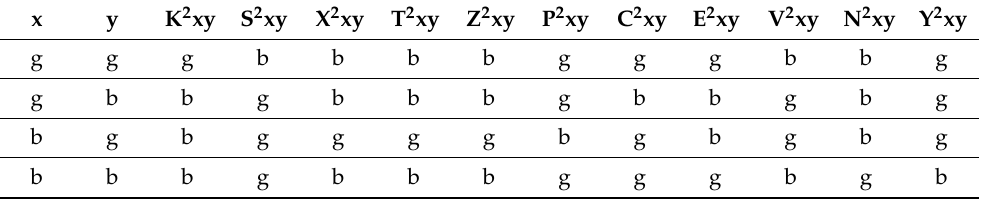
Table 2. Definition of the evaluation-functions determined by two